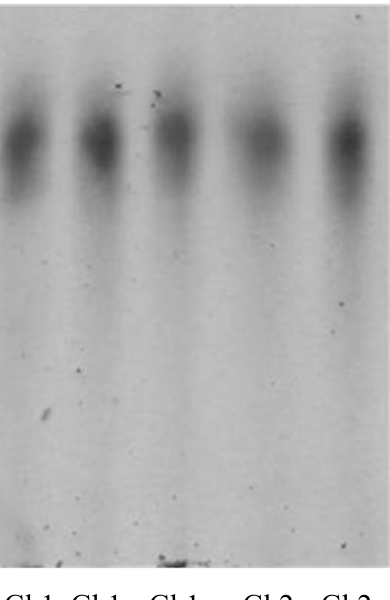
Figure 1. Agarose gel electrophoresis of the extracts from Gracilaria birdiae . About 5-µL aliquots (50 µg) of Gracilaria polysaccharides were applied in agarose gel (107.5